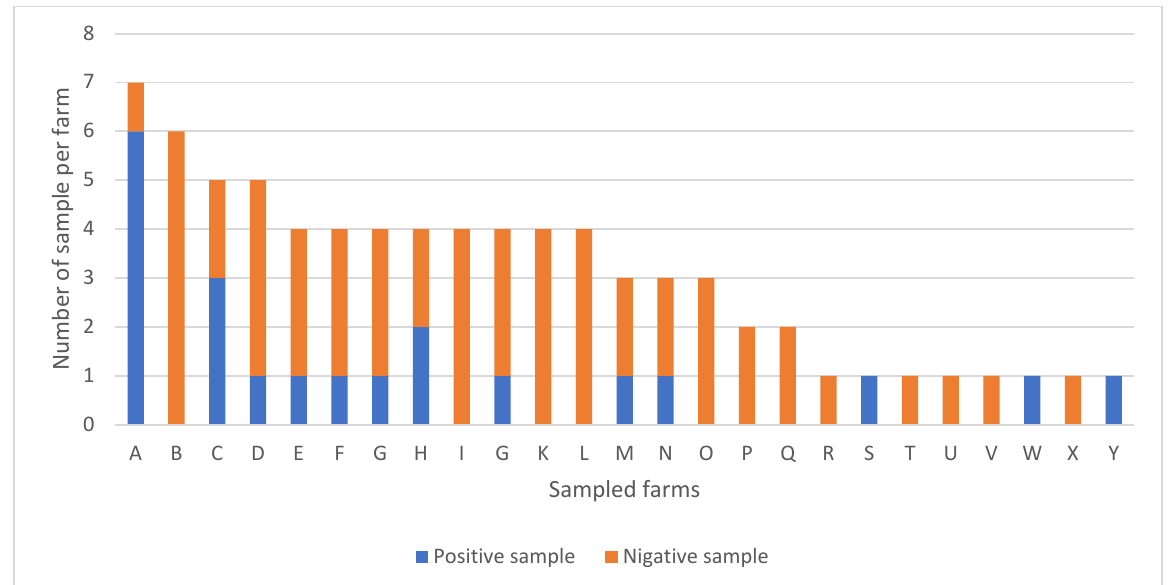
Figure 2. Results of bacterial cultures (positive vs. negative) according to the originate farm of sam- ples.